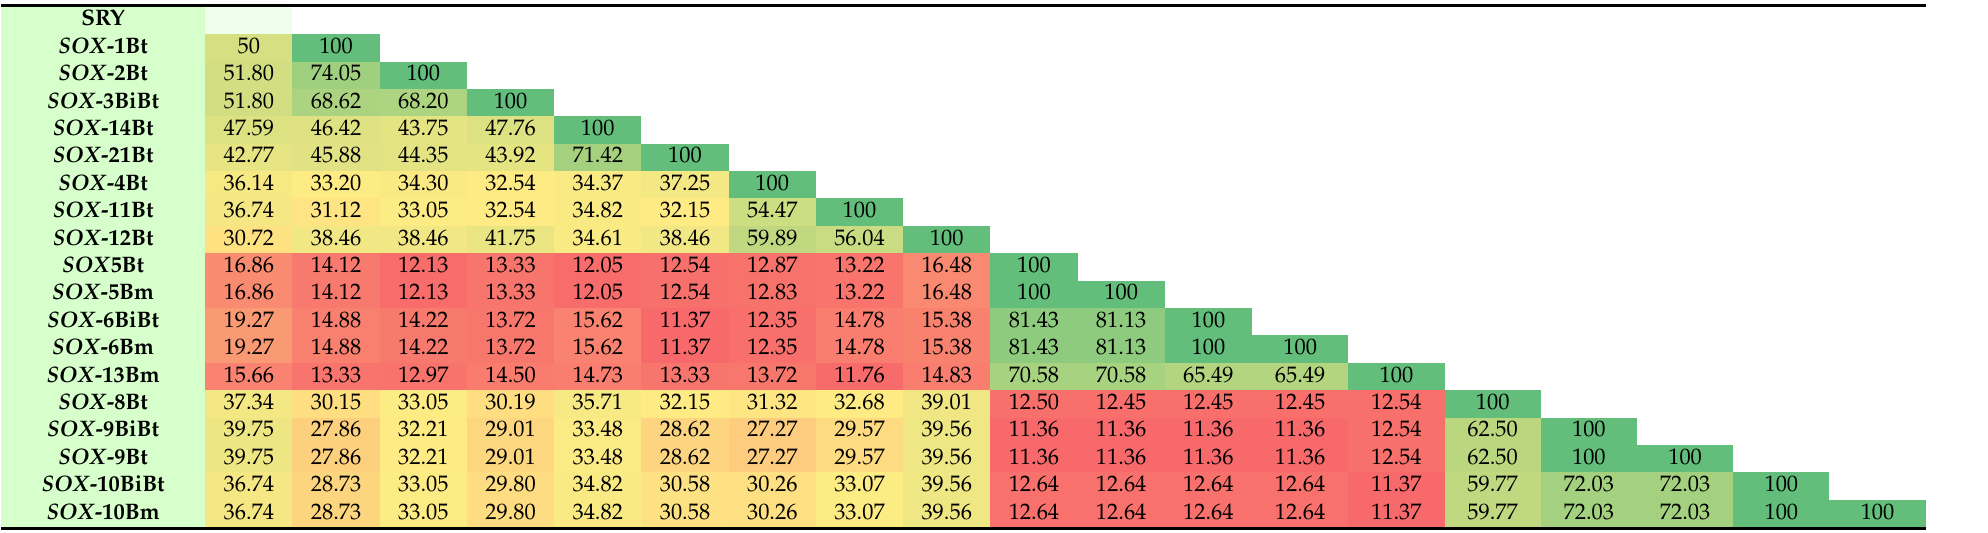
Table 2. Molecular similarity index of Sox gene family in